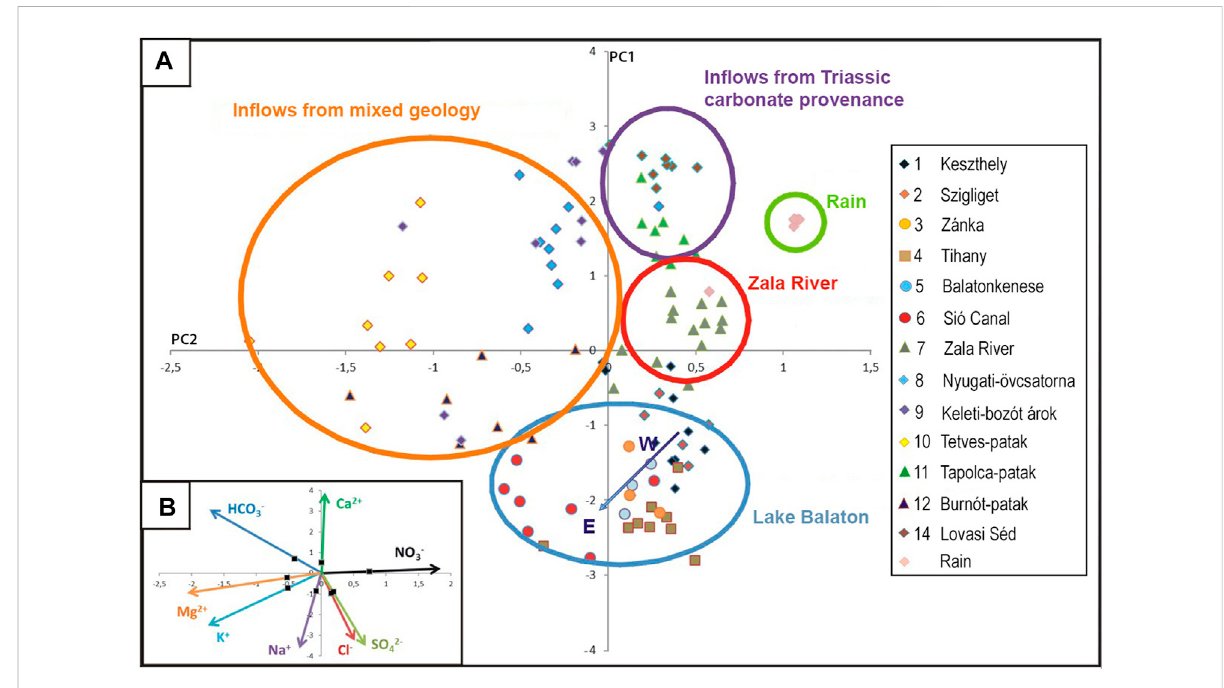
FIGURE 5 (A) Principal component and cluster analysis of water chemical parameters at the sampling sites in tributaries and Lake Balaton, based on concentrations of the ions HCO 3 − , NO 3 − , SO 4 2- , Cl − , Ca 2+ , Mg 2+ , Na + and K + . (B) Effects of increasing concentrations of analyzed ions, squares represent their